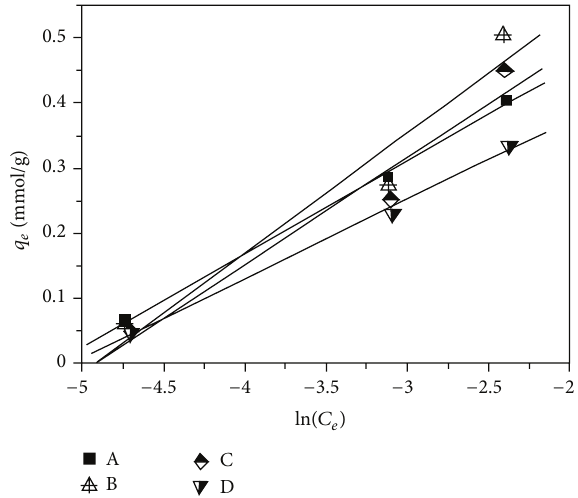
Figure 7: Plot of the Halsey isotherm model for lead(II) adsorption on samples